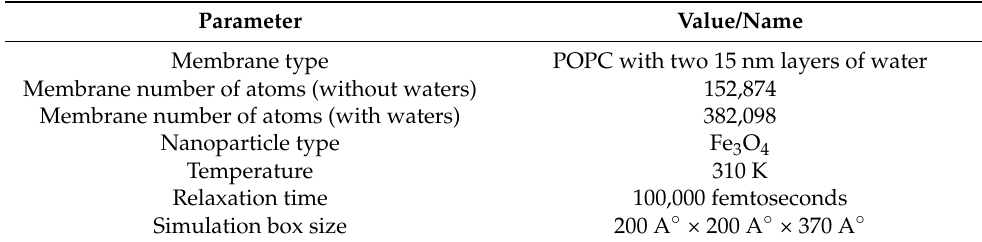
Figure 6. A single particle crossing the membrane in a molecular dynamic simulation. Table 2. MD parameters used in this